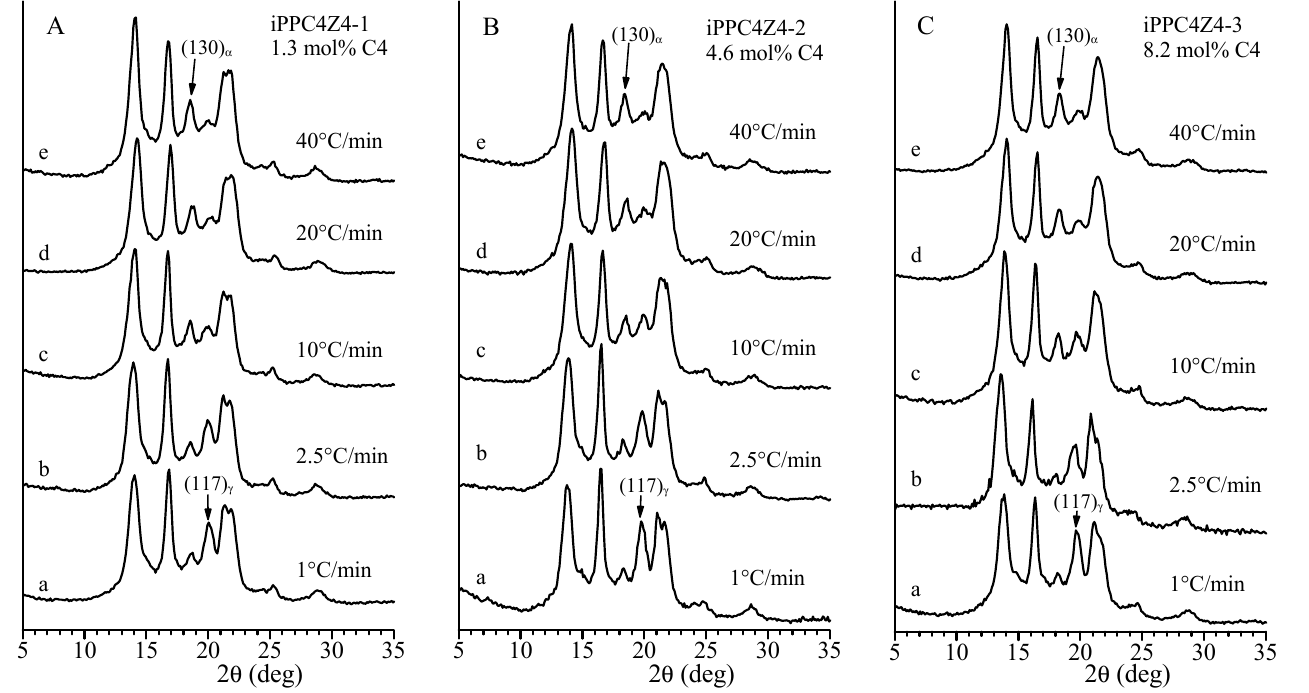
Figure 7. X-ray diffraction profiles of samples of copolymers iPPC4Z4-x crystallized from the melt by cooling the melt from 170 °C down to 25 °C at the indicated different cooling rates.